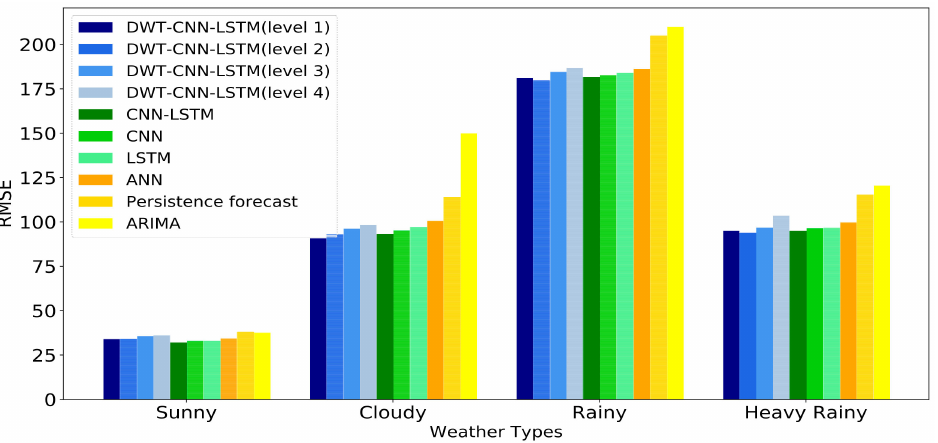
Figure 14. The RMSE of different forecasting models for sunny, cloudy, rainy and heavy rainy days using the dataset of Desert Rock